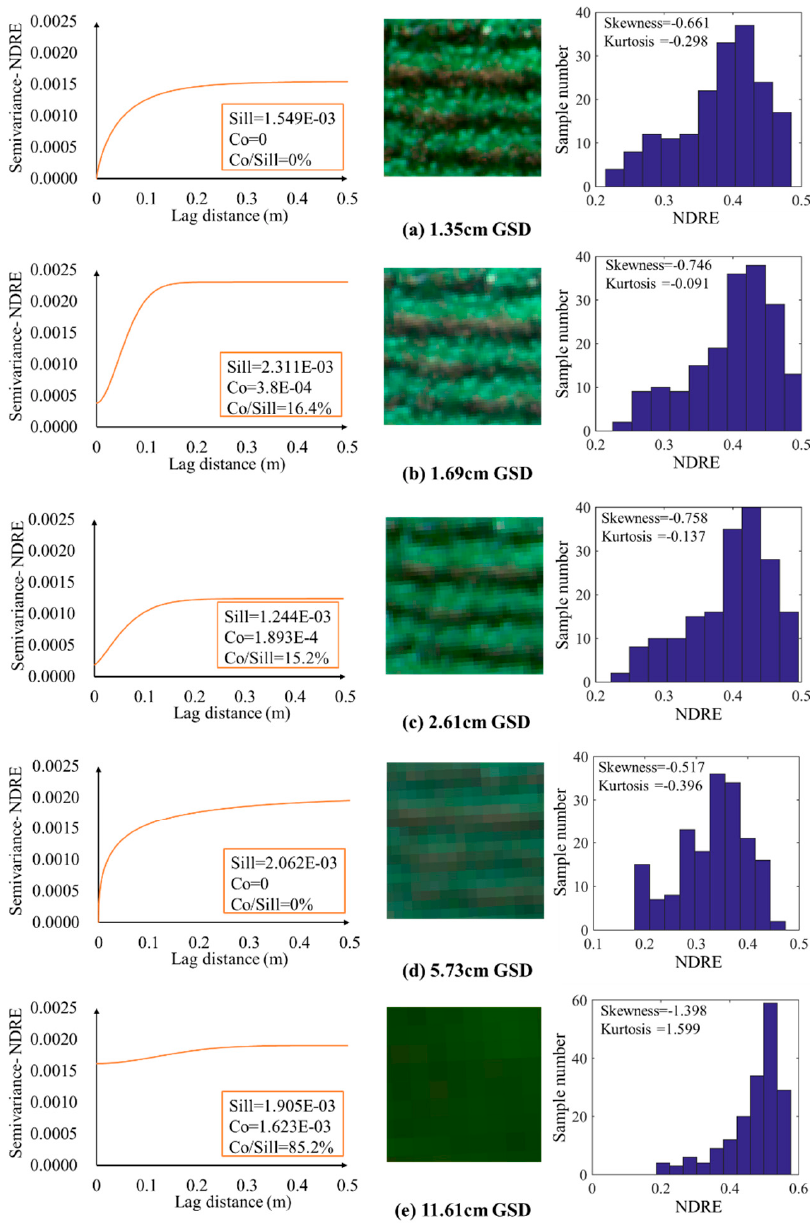
Figure 7. Semivariograms and distributions of NDRE values from in situ UAV images at different GSDs.